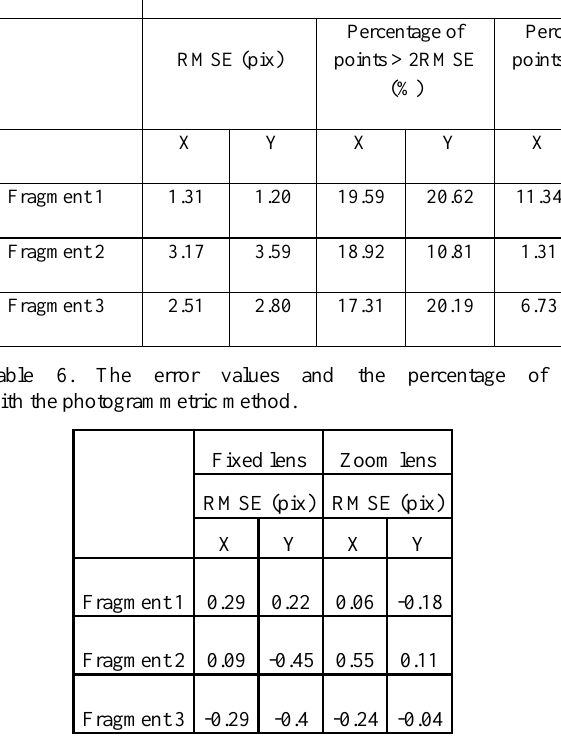
Table 7. The error differences between calibration performed with GCP and TLS